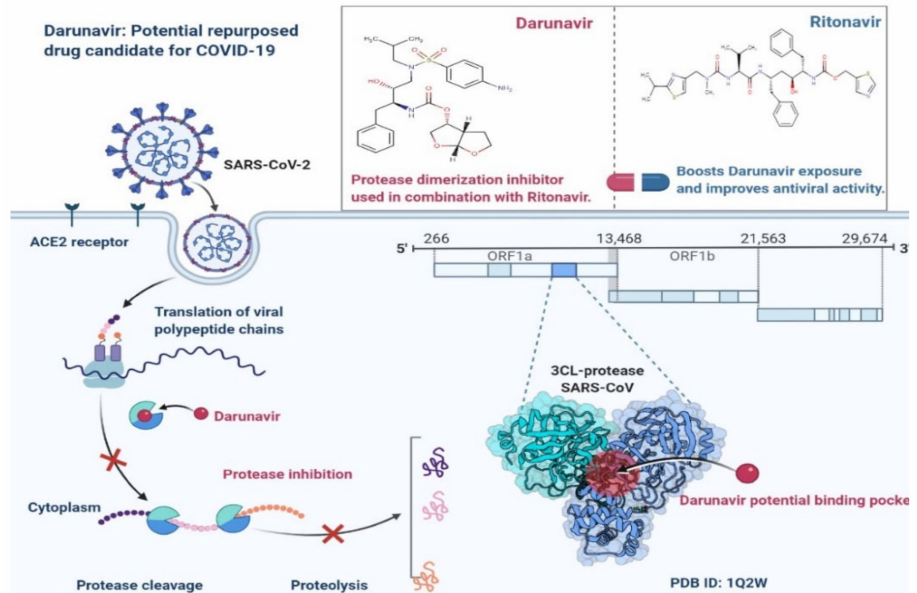
Figure 12. Darunavir: Potential Repurposed Drug Candidate for